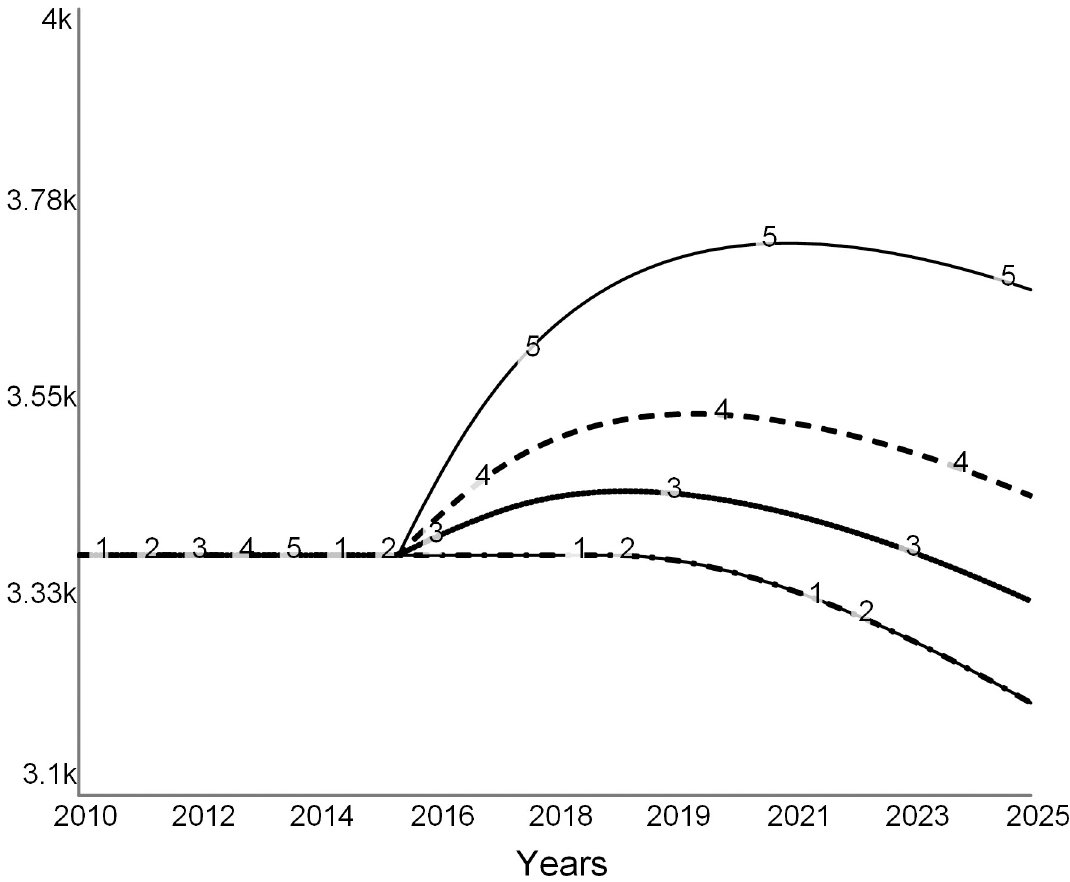
Fig 17. Student enrollments. Spending on facilities might give a short reprieve. Curve 1: base run. Curve 2: 0% increase in enrollments. Curve 3: 5% increase in enrollments. Curve 4: 10% increase in enrollments. Curve 5: 20% increase in enrollments.